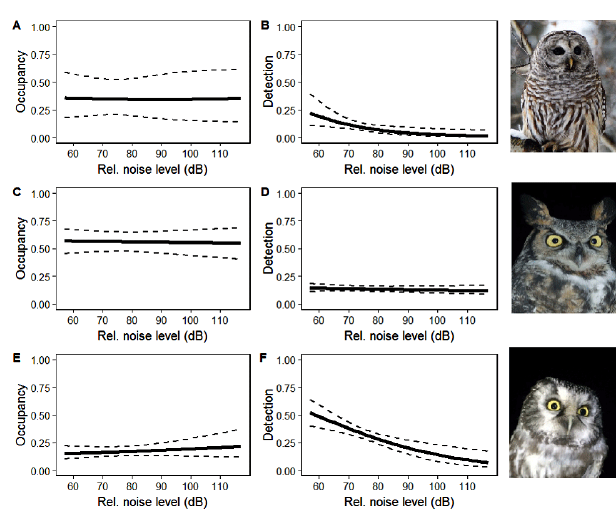
Fig. 5 . Station level model predictions of occupancy (left panels) and detection probability (right panels) for Barred Owls ( Strix varia ; A, B), Great Horned Owls ( Bubo virginianus ; C, D), and Boreal Owls ( Aegolius funereus ; E, F) across relative noise levels. Predictions are averaged from models within 4 Δ AIC model (Table 3). The solid lines are the model averaged predictions and the dashed lines are 95% confidence intervals. Owl photos by J.